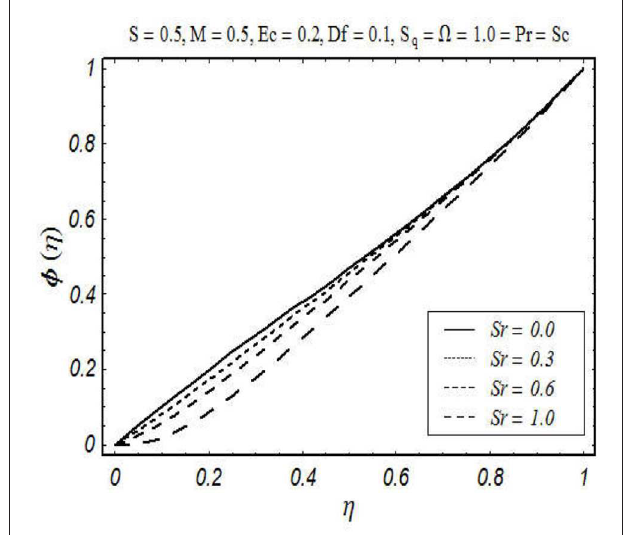
TABLE 1 | Numerical data for friction drag coefficients for varying S , (cid:127) , S q and M .